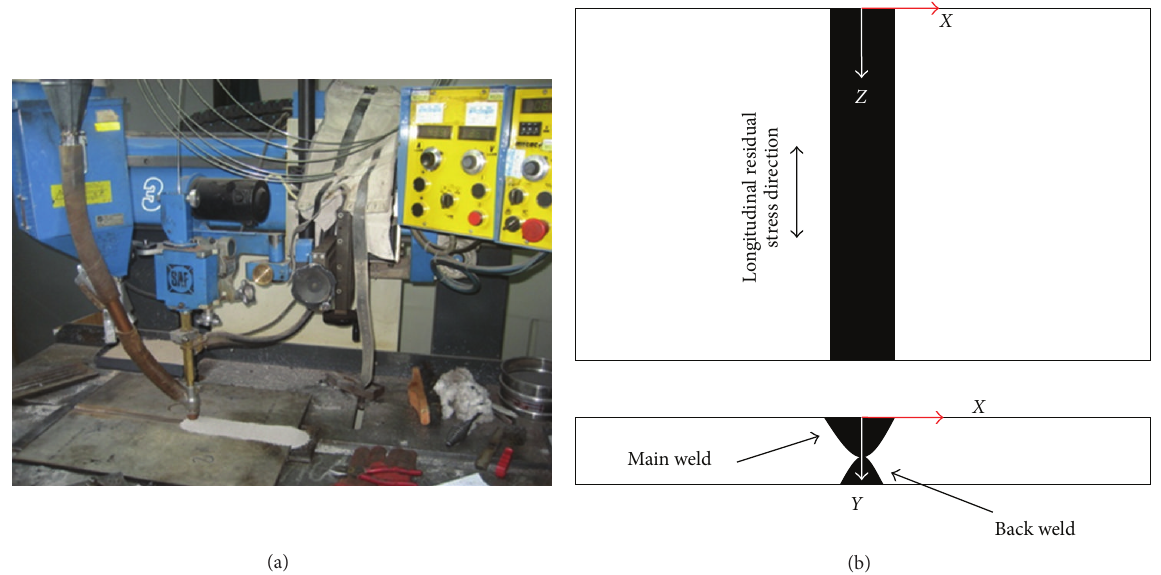
Figure 3: (a) SAW process on stainless steel plate and (b) schematic view of the welded plate.